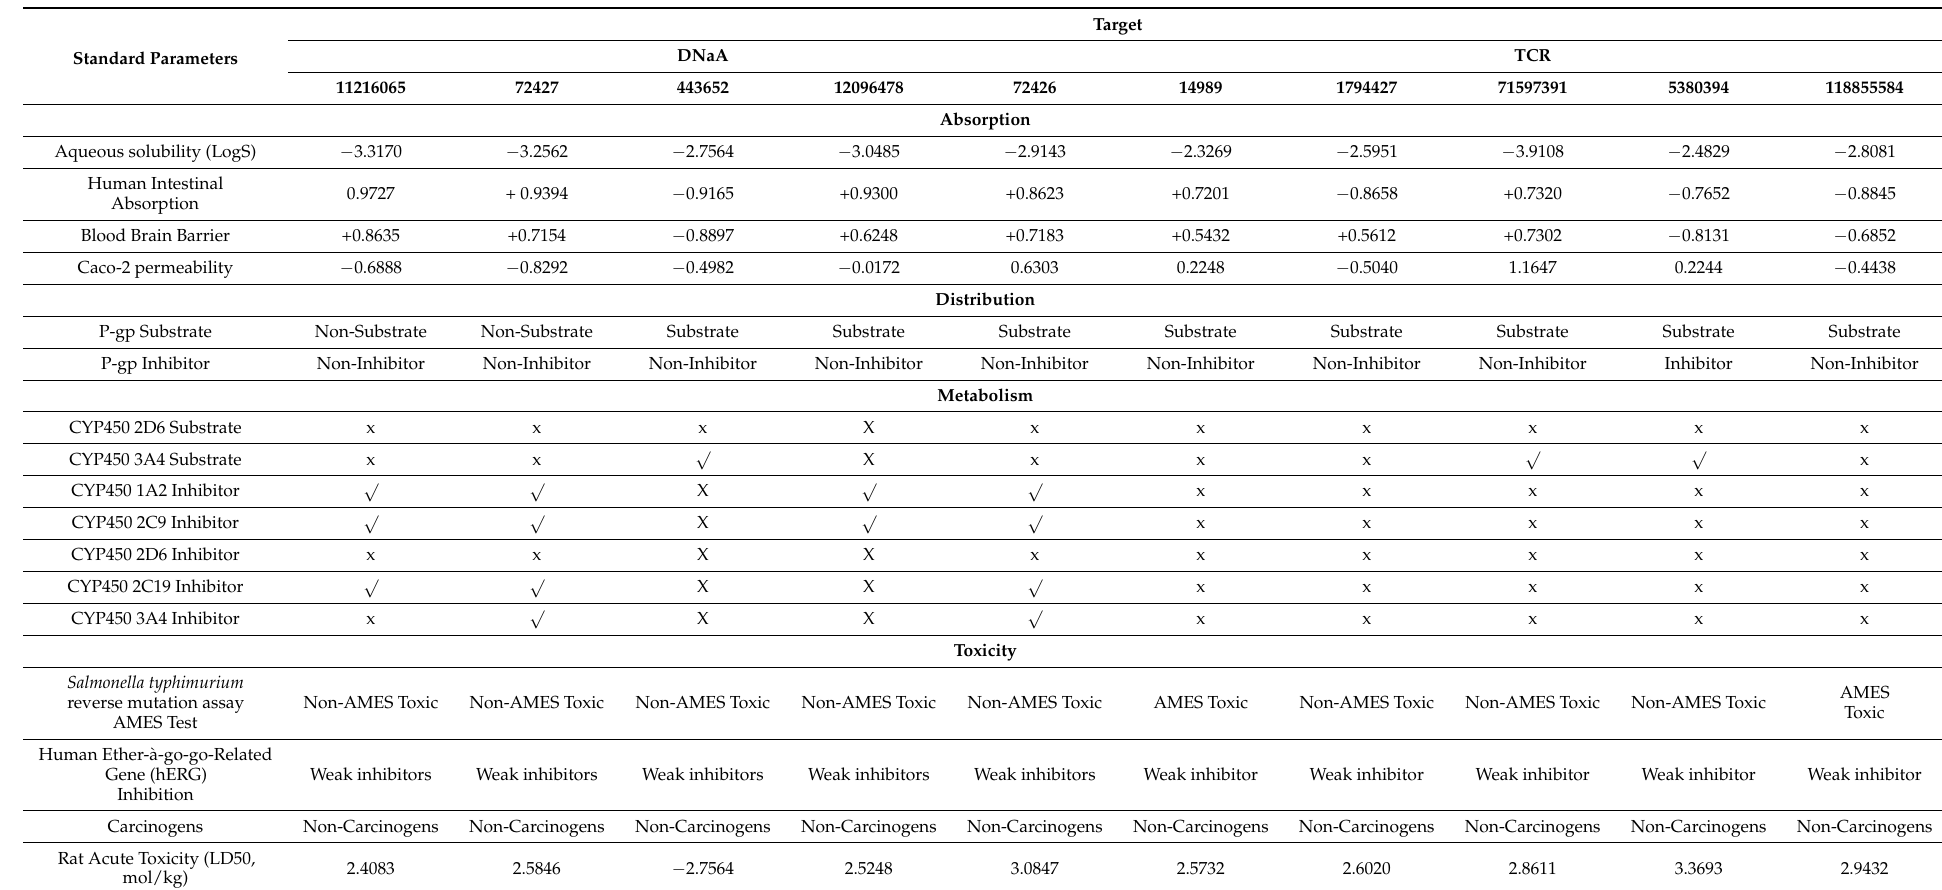
Table 5. Pharmacokinetic properties of the top predicted drug candidates for the DNaA and TCR